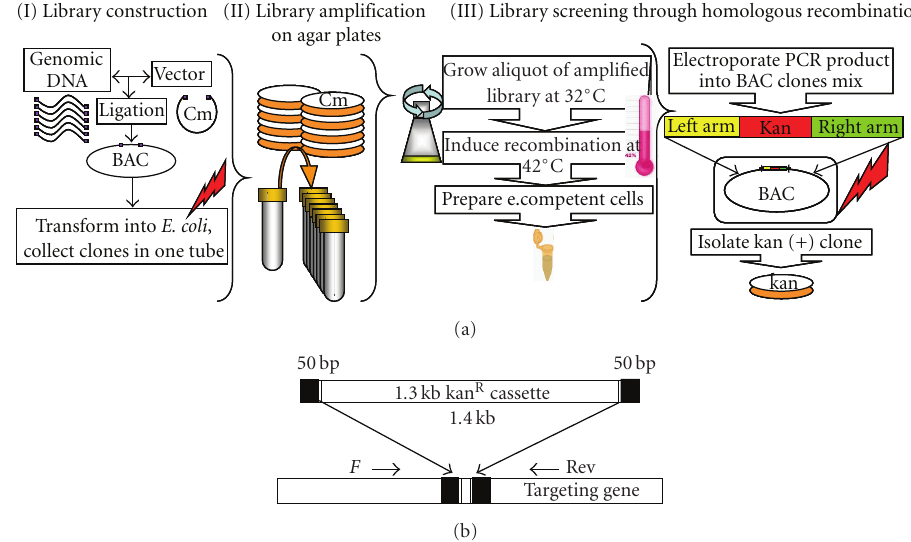
Figure 6: (a) Strategy for library screening through homologous recombination. There are 3 steps: (I) Library construction—consists of DNA ligation and E. coli transformation; (II) Library amplification—library is plated on Cm agar plates at high density, clones harvested by washing with LB. Glycerol stocks made of mixed clones; (III) Library screening via HR. An aliquot of the amplified library is grown at 32 ◦ C and induced at 42 ◦ C. Electrocompetent cells are prepared and transformed with HR cassette (Figure 6(b)). Recombinant clones were identified on kanamycin plates. (b) Recombination cassette. HR cassette consists of a 1.3 Kb kanamycin resistance gene flanked by 50 bp homology arms. kan R cassette is inserted into targeting gene using 50bp homology arms “H” corresponding to the targeted region. “F” and “Rev” are the flanking screening primers used for screening recombinant